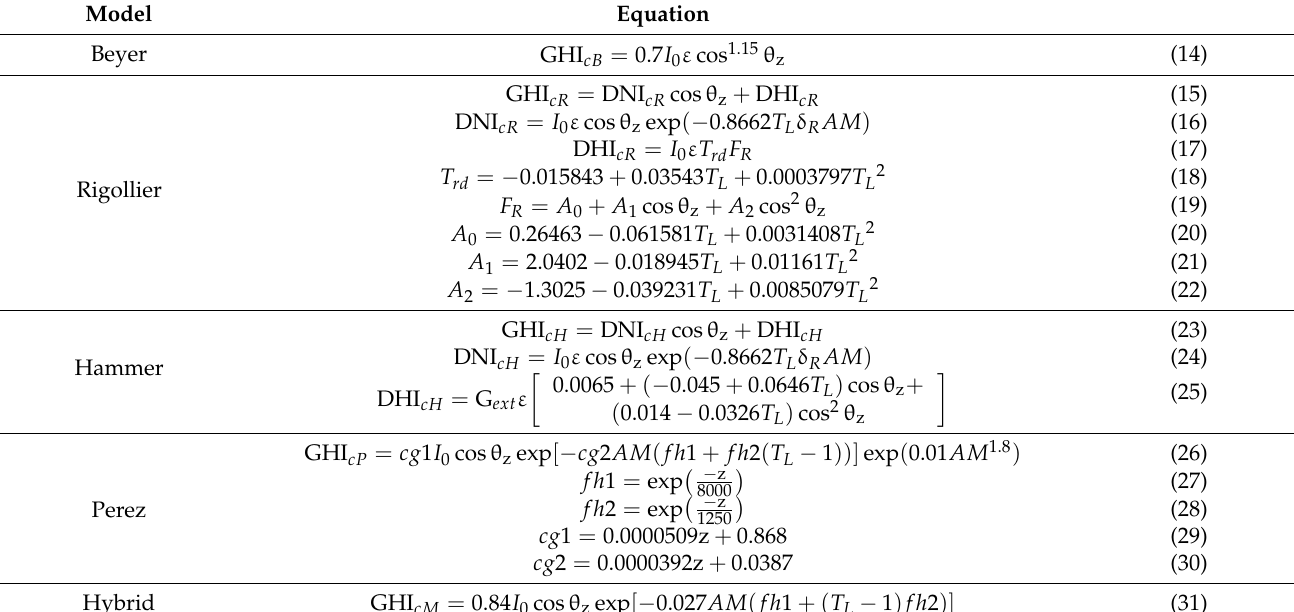
Table 3. Clear-sky irradiance formulas used for each semi-empirical model.